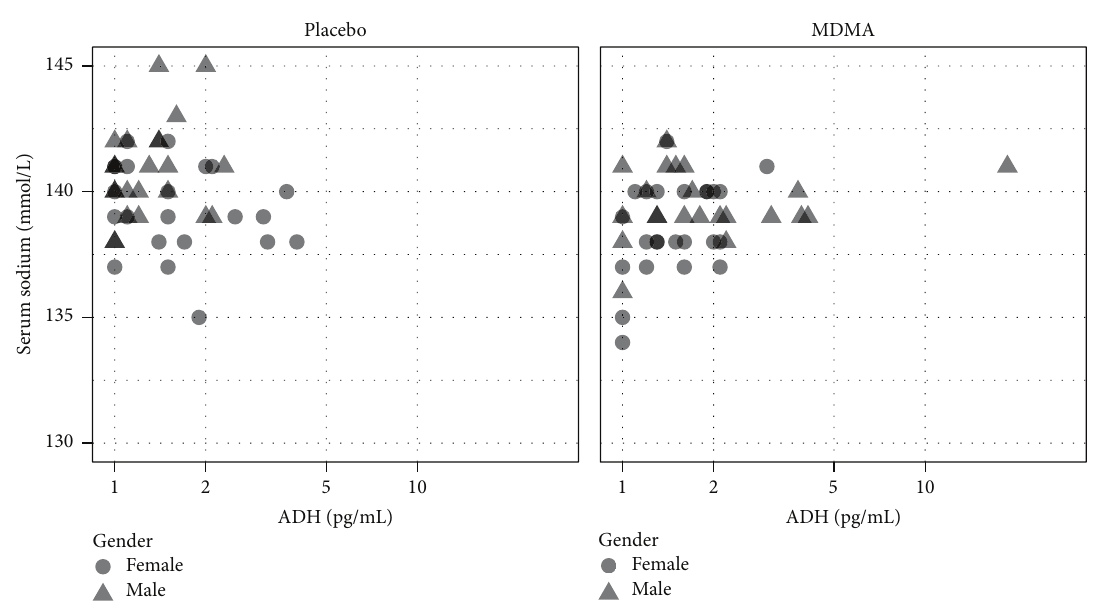
Figure 4: Relationships between antidiuretic hormone (ADH) and serum sodium at 1, 2, and 4 h after placebo and MDMA in Study 1.